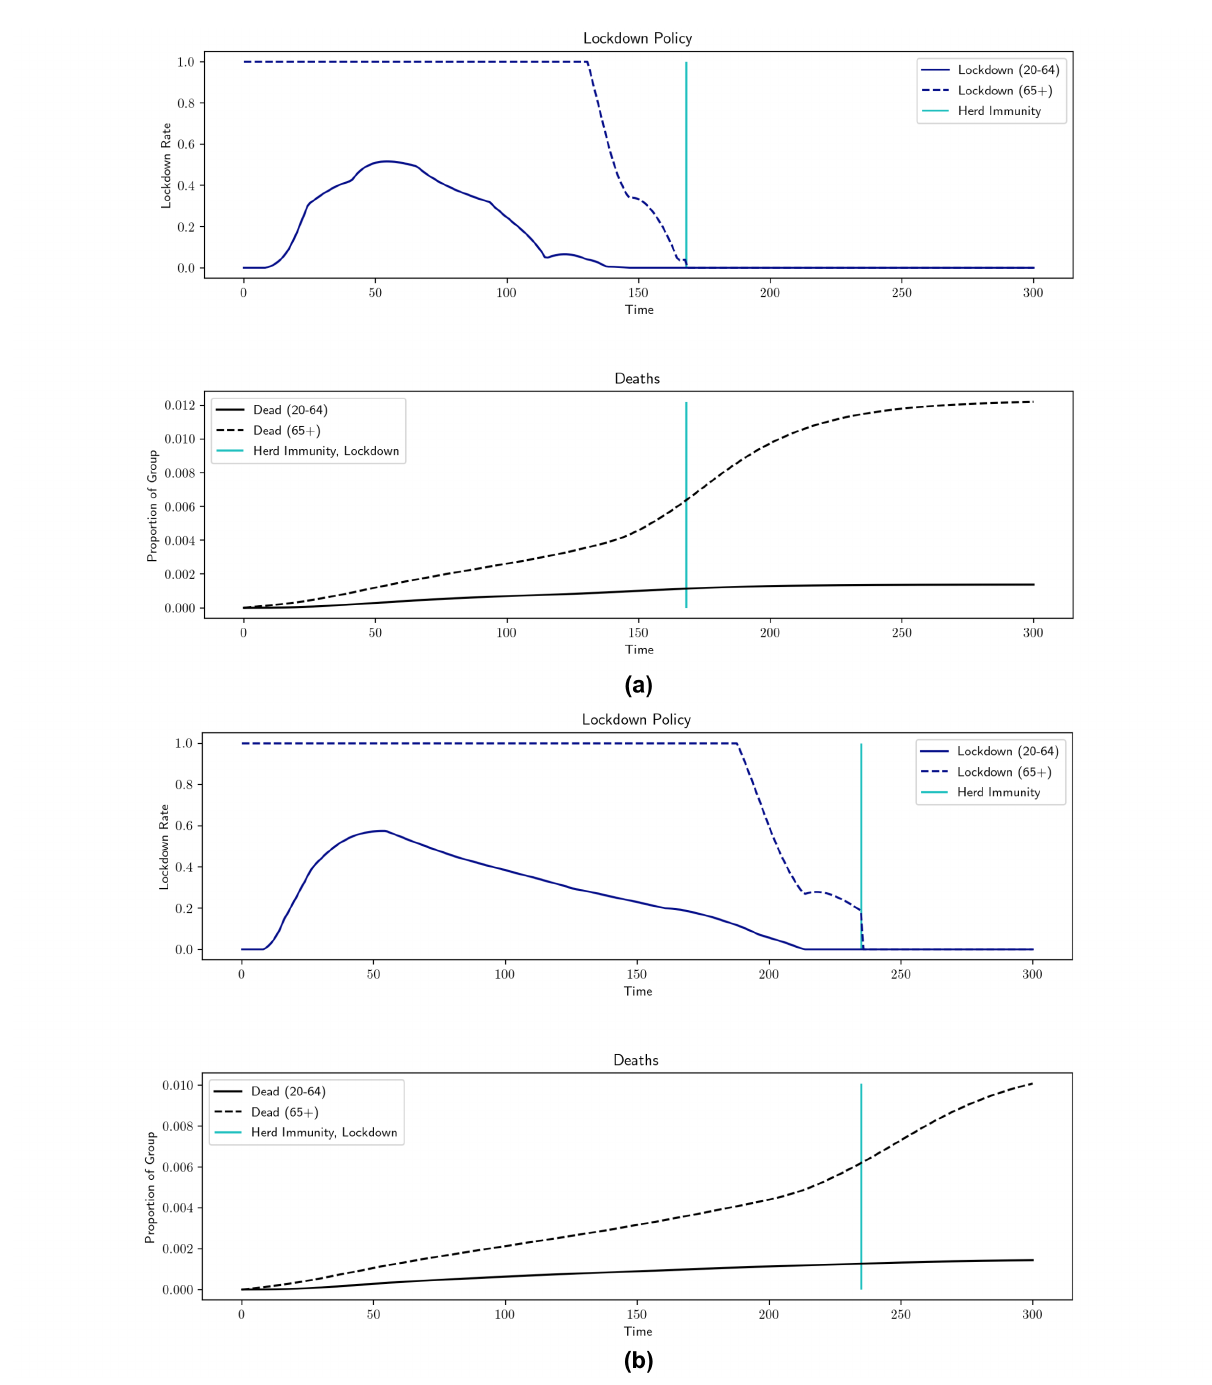
Figure 8. Robustness results for h (percentage of workforce that can work remotely). ρ = 0.75, χ = 10/ r , r = 0.001%, ν = 0.67, α L = 10 − 5 , α I = 1, α E = 0.42, η = 10, F = 1. ( a ) h = 0, lockdown: 168 d, output loss = 8.8592%, total deaths = 0.338%; ( b ) h = 0.60, lockdown: 235 d, output loss = 5.842%, total deaths =